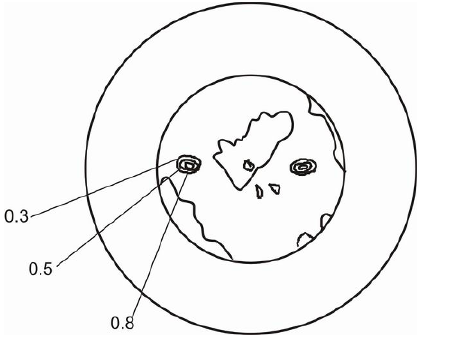
Figure 4. Pole figure {220} of CZT ceramics after compression at T = 25ºC, p = 400 MPa.